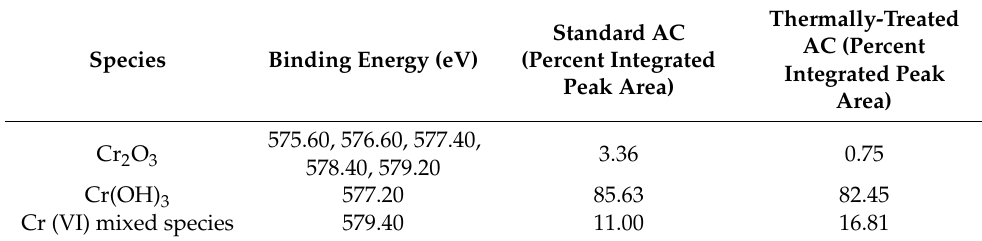
Table 5. Chromium atom percent speciation from deconvolution of the XPS Cr2p 3/2 peak post chromium adsorption [19,20,23].